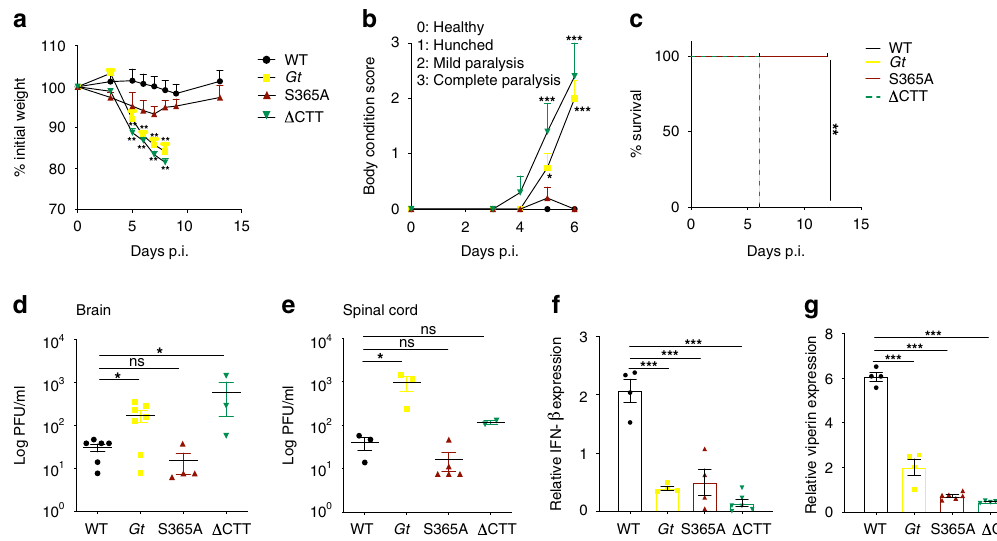
Fig. 3 S365A mice are partially resistant to systemic HSV-1 infection. Mice were intravenously infected with 1 × 10 6 PFU of HSV-1 (KOS strain). a Percentage of initial weight following infection. b Body condition score (BCS) of infected mice. c Survival of mice following infection. d Viral titers in the brain and e spinal cord at 6 days p.i. f Relative expression of Ifnb and g Viperin in the brain at 3 days p.i. All mice except C57BL/6J WT were bred in-house. a – c n = 7 mice per genotype, ( d ) n = 6/7/4/3, ( e ) n = 3/3/4/3, ( f ) n = 4/3/4/4, and ( g ) n = 4/4/6/6. Representative of at least three independent experiments, each yielding similar results. Center and error bars show mean and SEM. Analyzed with one-way ANOVA and Tukey post test. * p ≤ 0.05; ** p ≤ 0.005; *** p ≤ 0.0001. ns not signi fi cant. Exact p values are given in the Supplementary